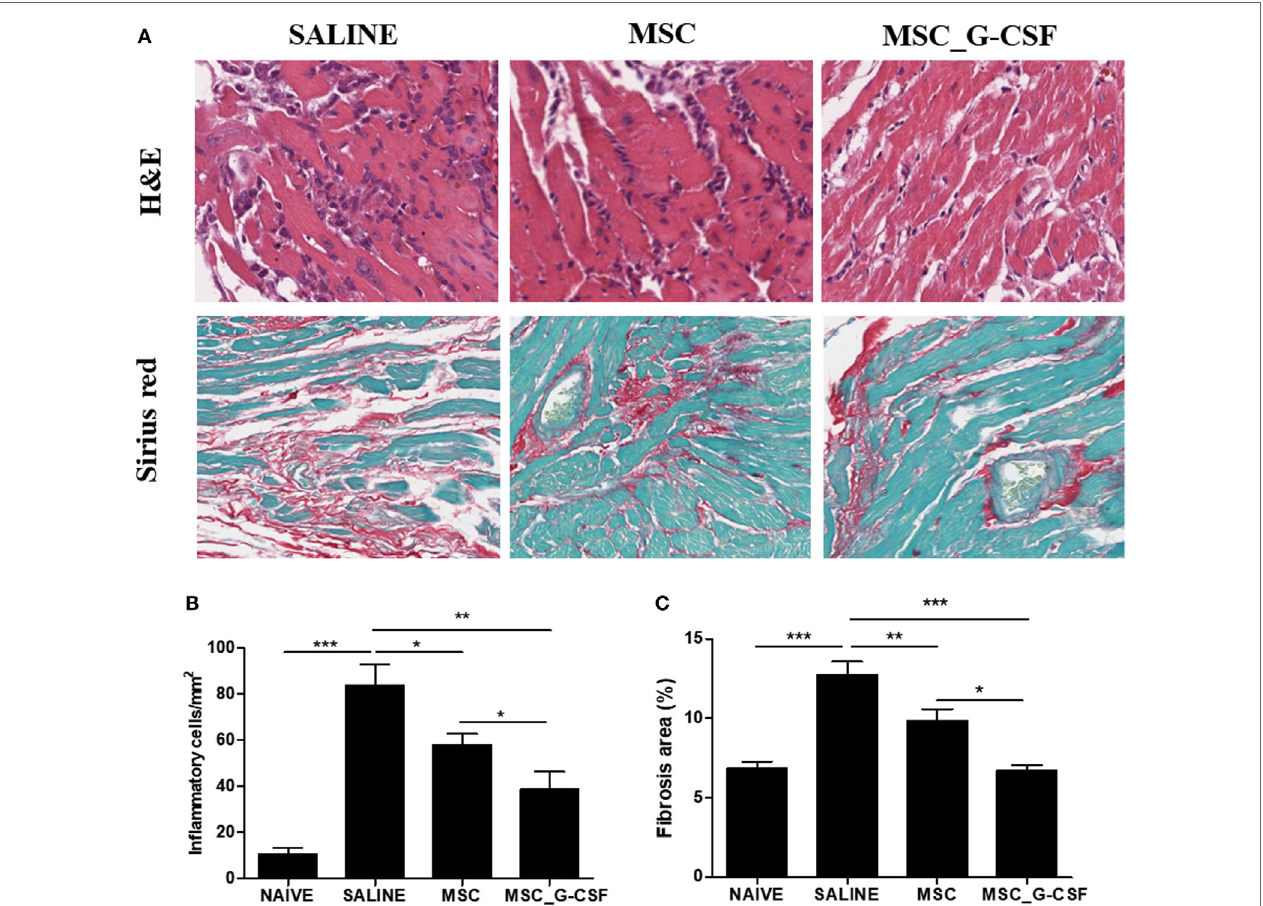
FigUre 6 | Reduction of heart inflammation and fibrosis after treatment with mesenchymal stem cells (MSCs). Hearts of naïve and Trypanosoma cruzi -infected mice treated with MSCs, MSC_G-CSF, or saline were evaluated 60 days after the beginning of treatment. (a) Heart sections of saline, MSCs, and MSC_G-CSF-treated mice stained with hematoxylin and eosin (H&E) or Sirius red. Infiltrating inflammatory cells (B) and fibrosis area (c) were quantified in heart sections by morphometrical analysis in sections stained with H&E or Sirius red, respectively. Values represent the mean ± SEM of 7–9 mice/group. * P < 0.05; ** P < 0.01; *** P < 0.001. Magnification = 400 × for H&E images and 200 × for Sirius red